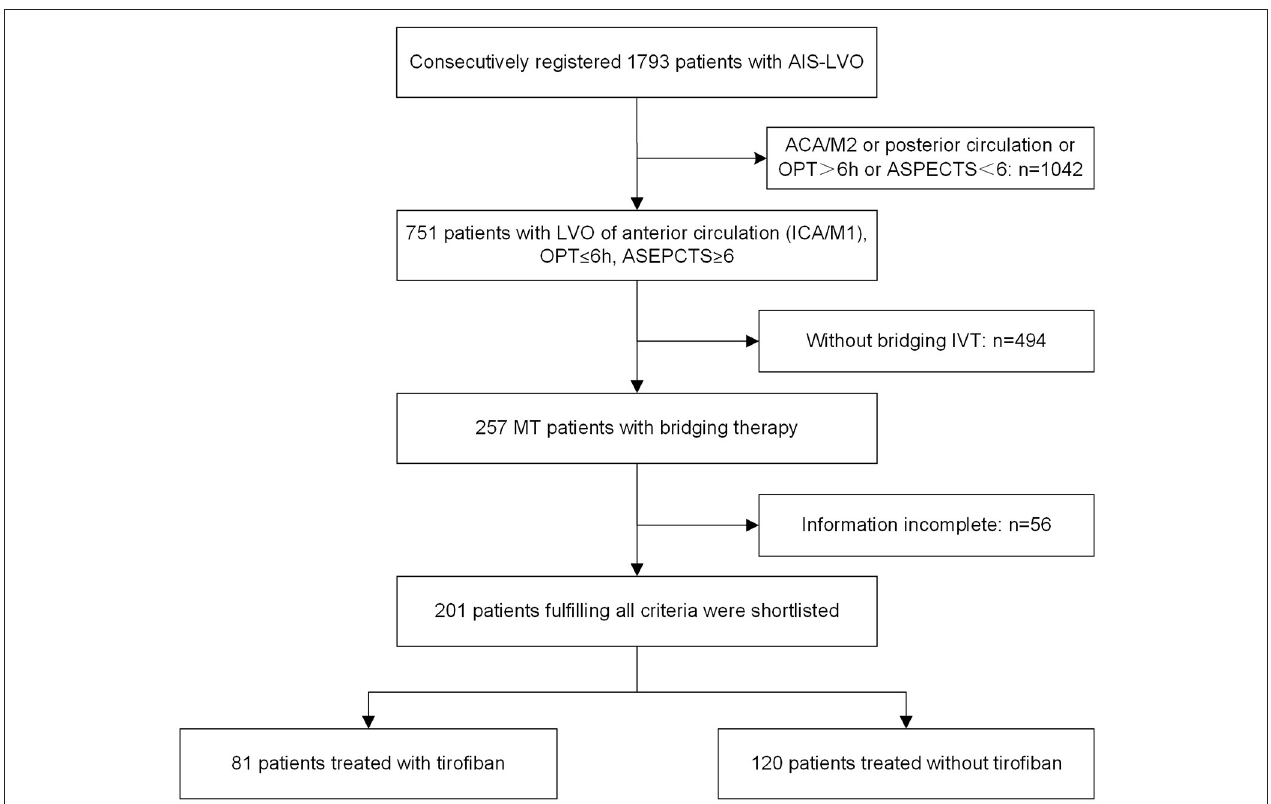
FIGURE 1 | Flowchart. ACA, anterior cerebral artery; AIS, acute ischemic stroke; ASPECTS, Alberta Stroke Program Early CT Score; ICA, internal carotid artery; IVT, intravenous thrombolysis; LVO, large vessel occlusion; M1, M1 segment; M2, M2 segment; MT, mechanical thrombectomy; and OPT, onset-to-puncture